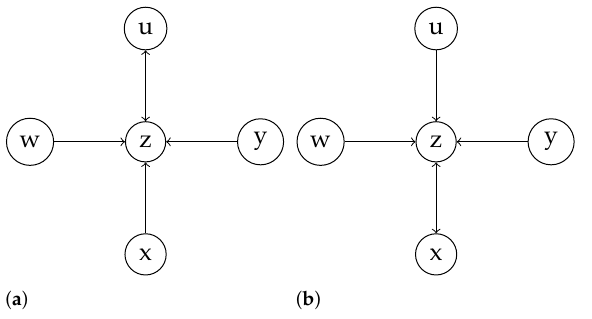
Figure 14. Causality diagrams for the 1st variant: bilateral causal relationship between ( a ) u and z and ( b ) x and z .